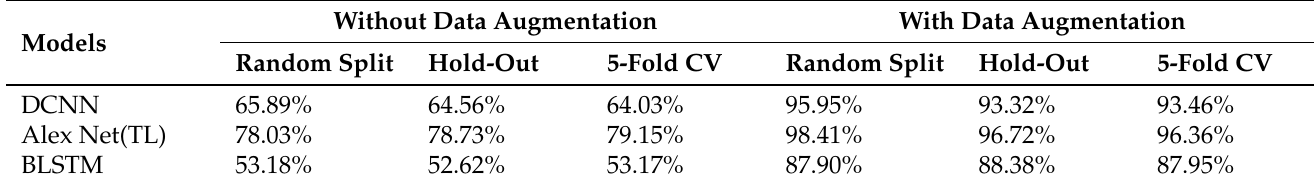
Table 4. Alphabet classification with and without data augmentation.